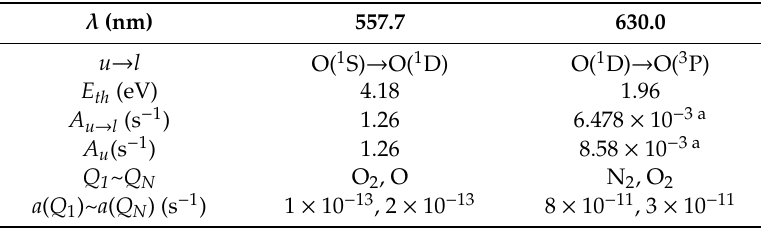
Table 2. Parameters used in the electron transport model.